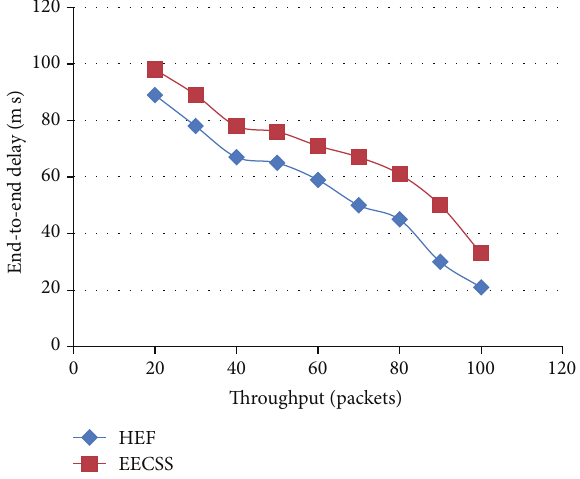
Figure 3: Number of nodes versus delivery ratio.